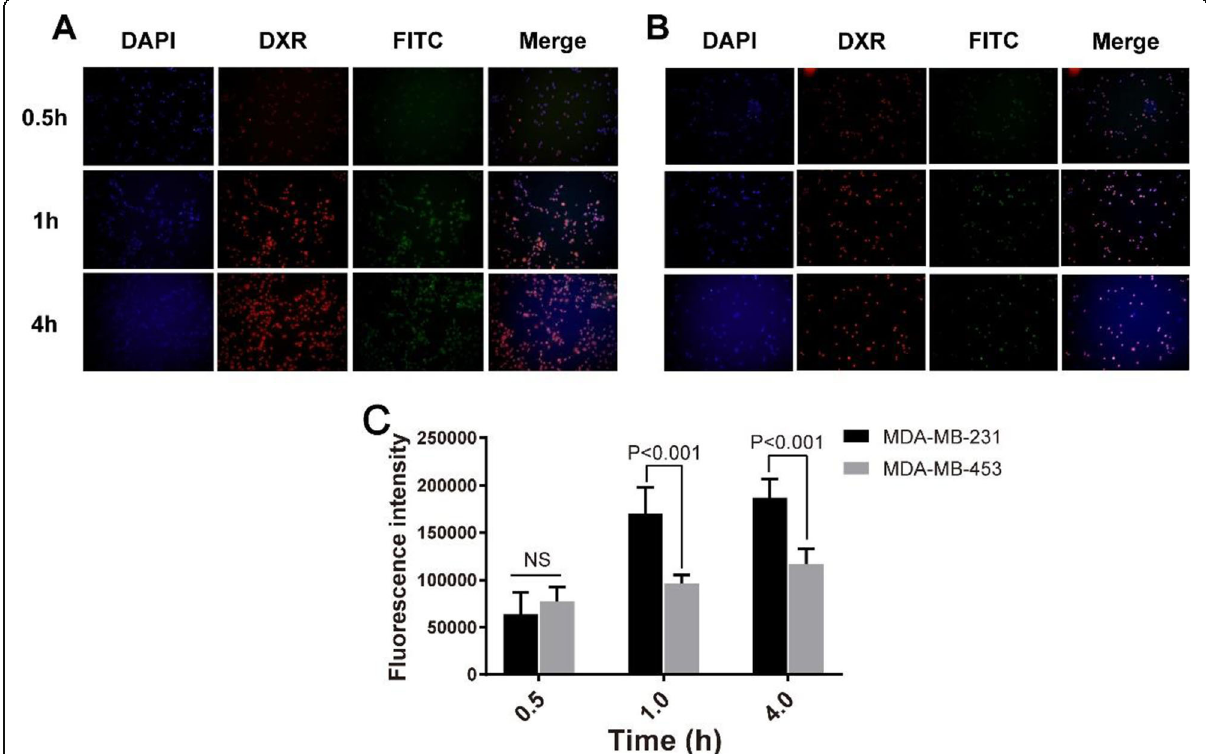
Fig. 6 Breast cancer cell uptake of drugs loaded in PLV/DXR NPs. Fluorescence microscopy images of FITC-loaded PLV/DXR taken up by MDA-MB-231 ( a ) and MDA-MB-453 ( b ) cells at 0.5, 1, and 4 h (blue for DAPI, red for DXR, green for FITC). c Quantitative analysis of cellular